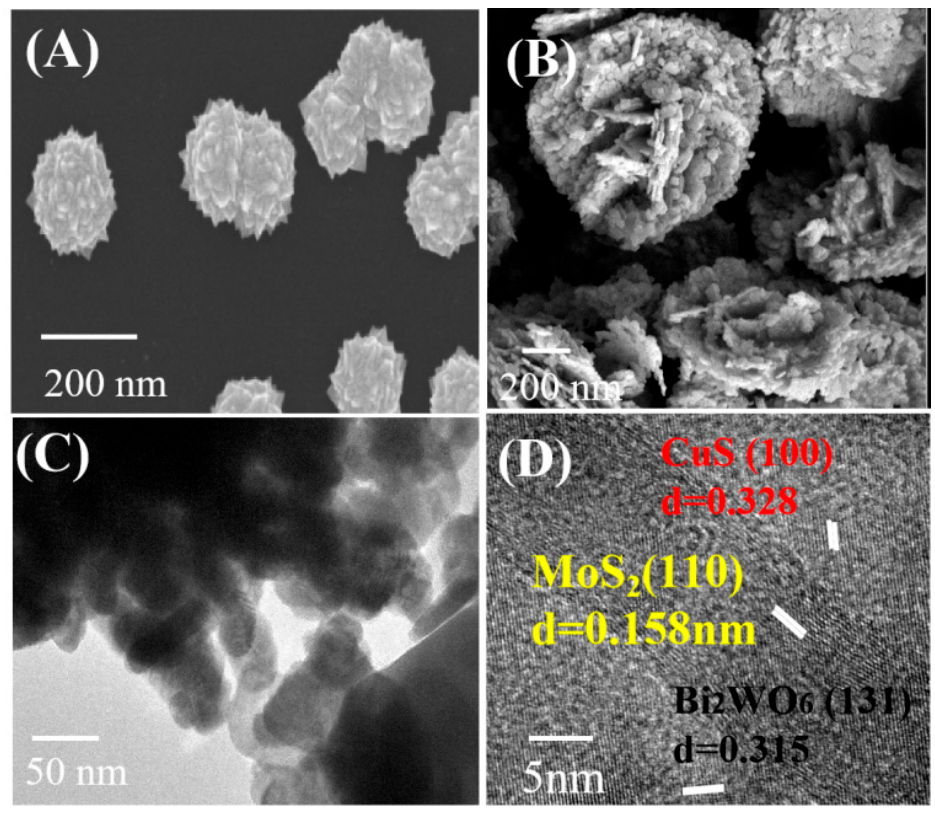
Figure 3. SEM images of Bi 2 WO 6 ( A ) and SEM and TEM images CuS/MoS 2 /Bi 2 WO 6 -5% ( B , C ); HRTEM image of the CuS/MoS 2 /Bi 2 WO 6 -5% ( D HRTEM image of the CuS/MoS 2 /Bi 2 WO 6 -5% ( D ).